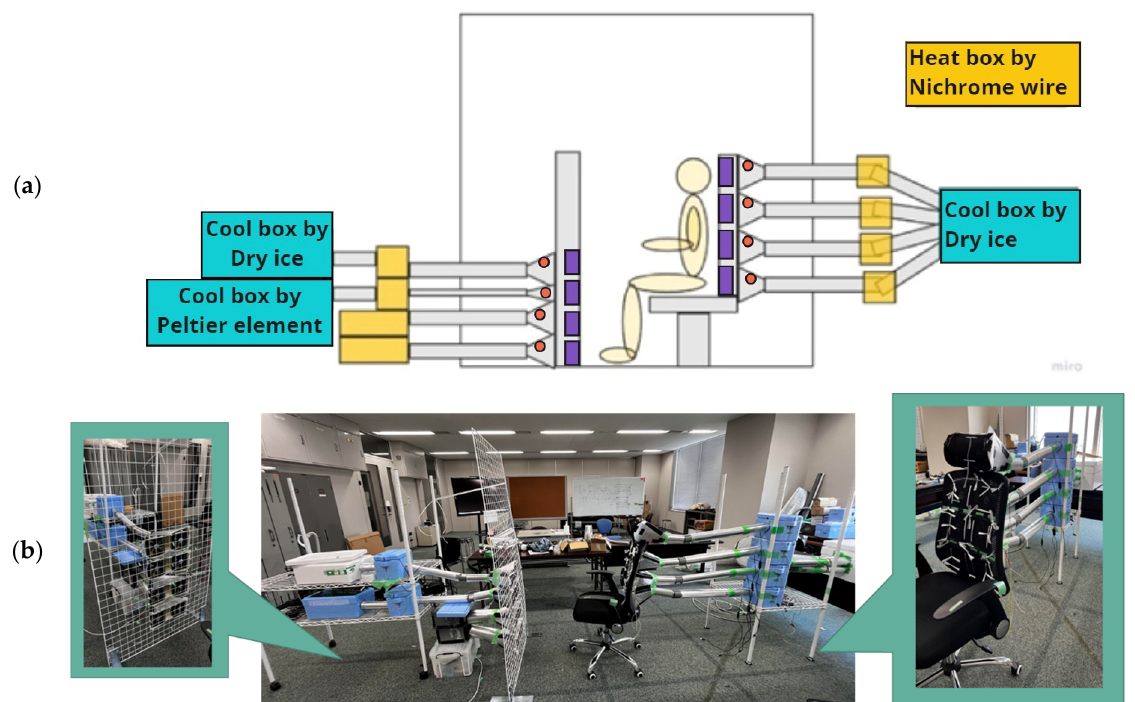
Figure 8. ( a ) Proposed air conditioning system and its experimental environment; ( b ) practical system used in verification experiment.